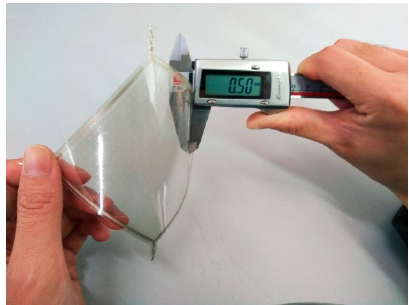
Figure 15. Thickness of the sensor sample.